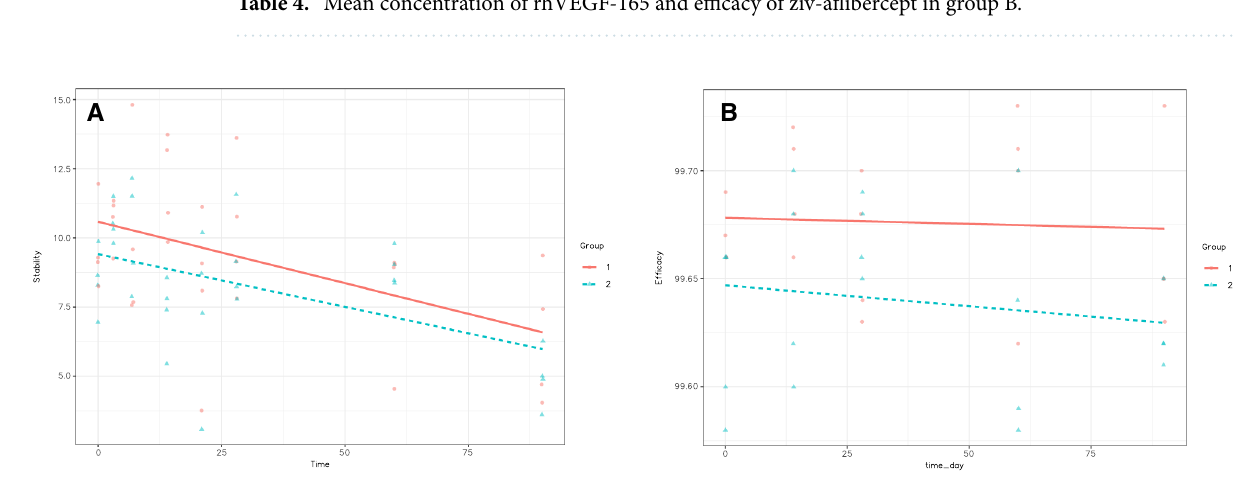
Table 4. Mean concentration of rhVEGF-165 and efficacy of ziv-aflibercept in group B.